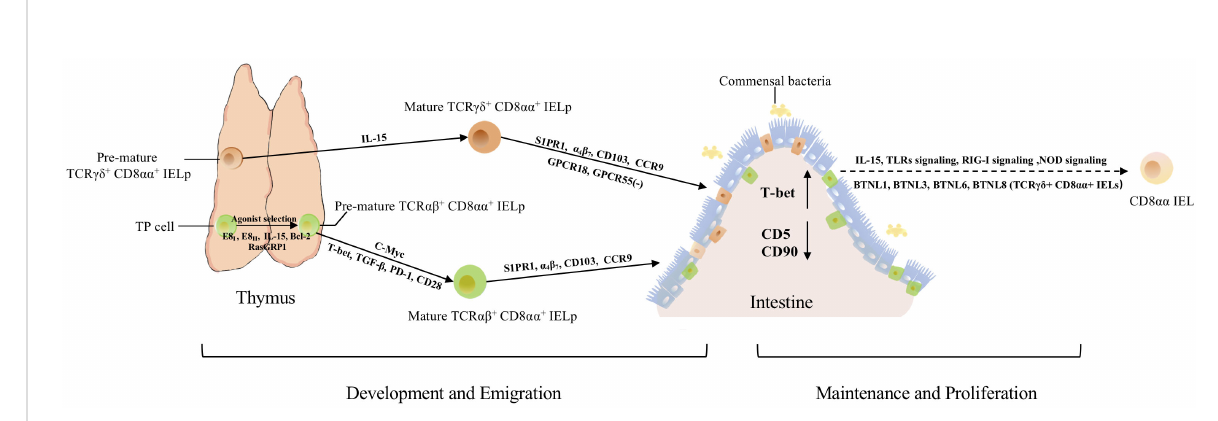
FIGURE 2 The development, migration, maintenance, and proliferation of TCR ab + CD8 aa + and TCR gd + CD8 aa + IELs. Both types arise from thymic IELps. TP cells become DN cells by regulation from E8I, E8II, IL-15, Bcl-2, and RasGRP1. E8I and E8II can suppress the expression of CD8 ab . RasGRP1 contributes to the transmission of weak TCR signals in the process of selection. Besides, c-Myc controls the development of TCR ab + CD8 aa + IELps via IL-15 and Bcl-2. After agonist selection, pre-mature TCR ab + CD8 aa + IELps further develop with the help of T-bet, TGF- b , and PD-1. Mature TCR ab + CD8 aa + IELps migrate to the intestine directly with the help of S1PR1, a 4 b 7, CD103, and CCR9. Besides these molecules, TCR gd + CD8 aa + IELps also require GPCR18 and GPCR55 for localization and regulation of their accumulation. After IELps arrive in the intestine, the expression of CD5 and CD90 is downregulated, while the expression of T-bet is upregulated, exhibiting the phenotype of CD8 aa . Meanwhile, the crosstalk between commensal bacteria, IECs, and CD8 aa IELs contributes to the maintenance and proliferation of CD8 aa cells, via NOD2 signaling, TLRs signaling, RIG-I signaling, IL-15, and other signaling pathways. In addition, BTNL1, BTLN3, BTNL6 and BTNL8 could promote the maturation and expansion of gd